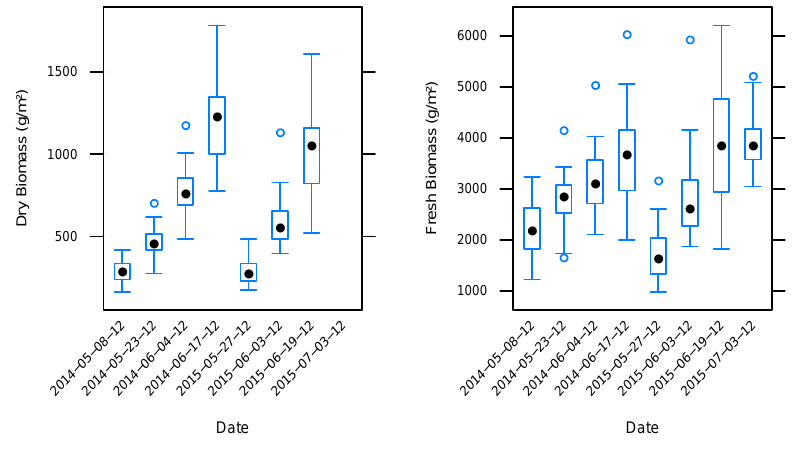
Figure 3. Boxplot of measured dry and fresh biomass